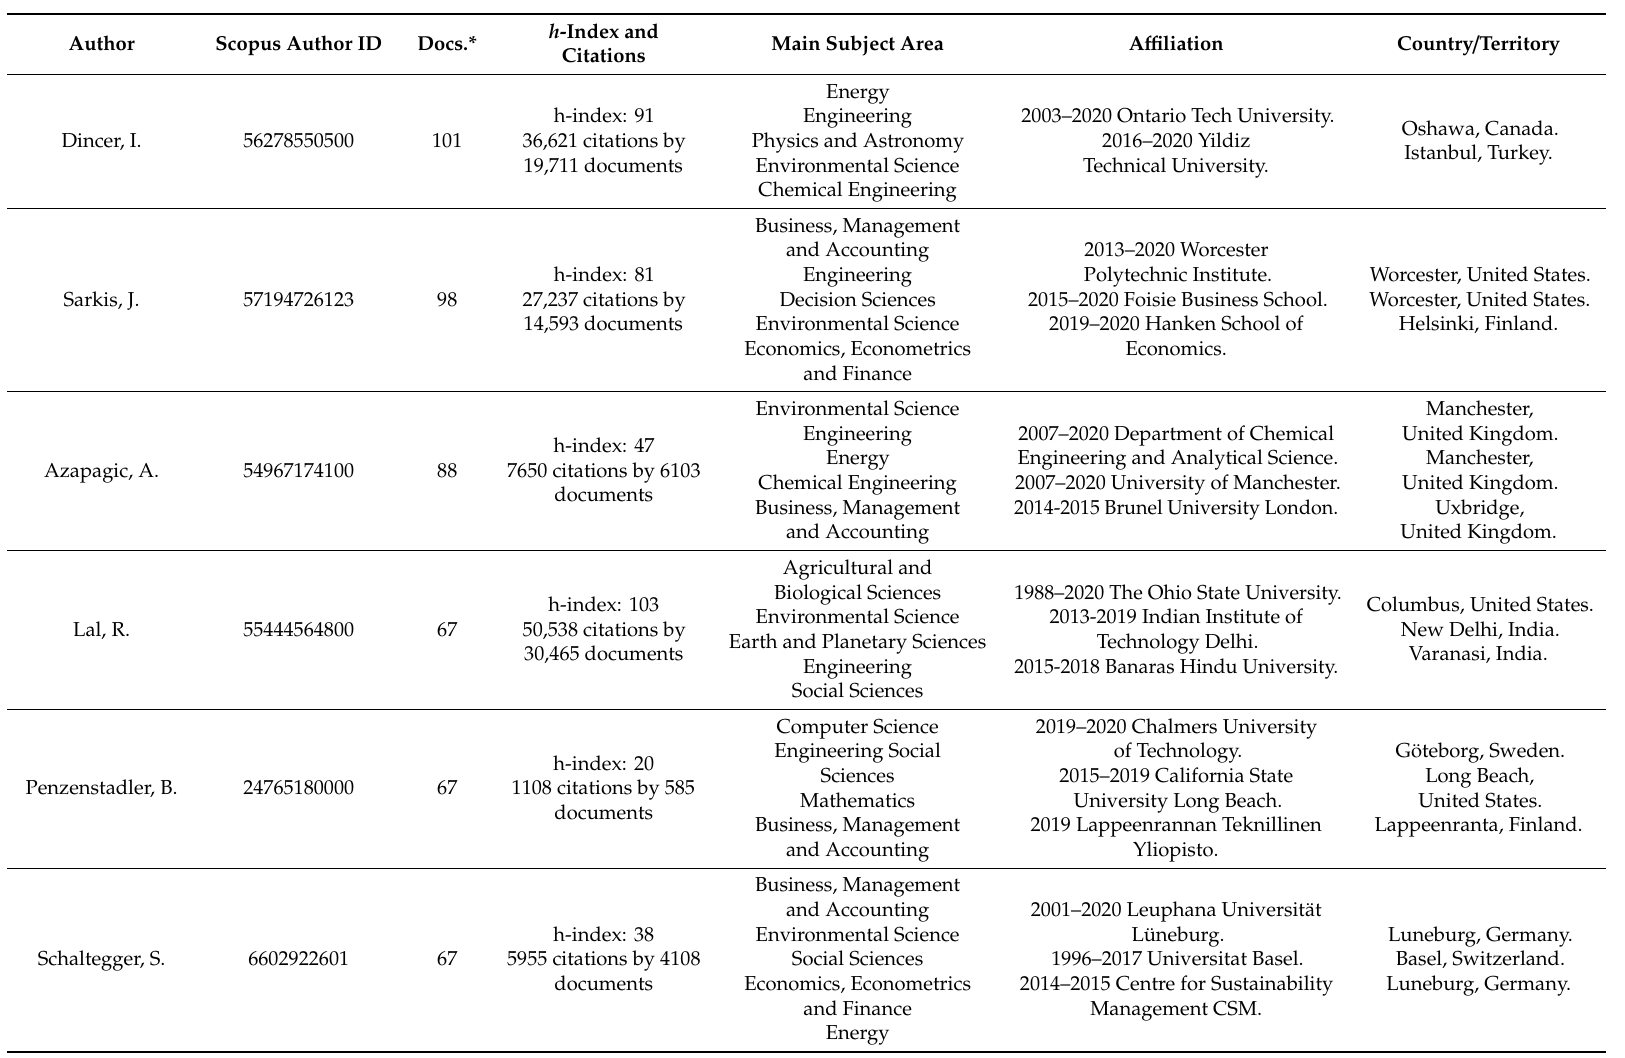
Table 3. Leading authors on sustainability in the last 10